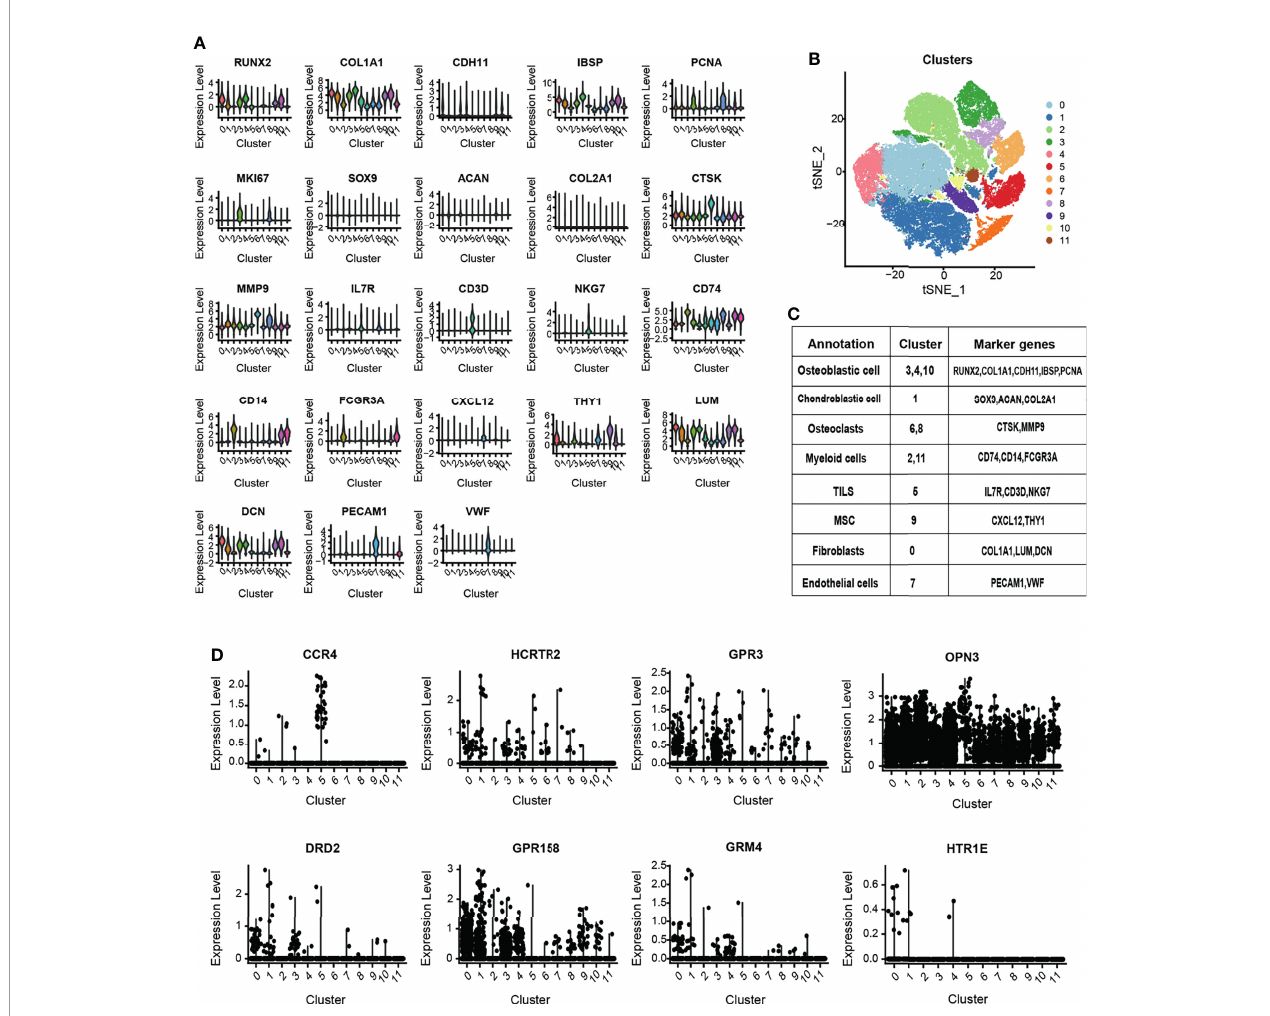
FIGURE 8 | (A) The violin plot shows the expression level of canonical biomarkers in each cell population. (B) The tSNE plot shows the distribution of each cell population. (C) Use the canonical markers to annotate the 12 distinct clusters in OS. (D) OS single-cell atlas to identify the expression and distribution of the GPCRs in the OS